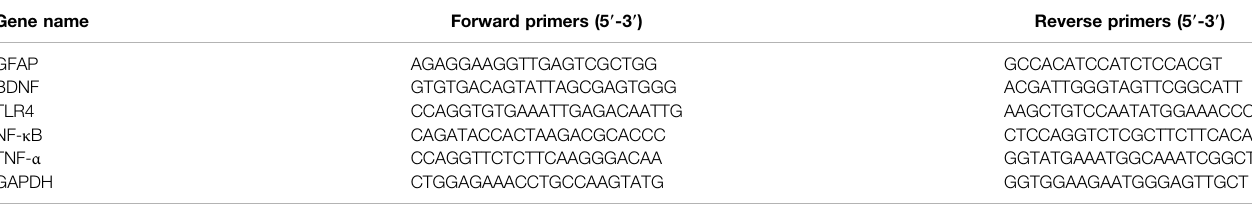
GFAP, glial fi brillary acidic protein; BDNF, brain-derived neurotrophic factor; TLR4, toll-like receptor 4; NF- κ B, nuclear transcription factor-kappa B; TNF- α , tumor necrosis factor α ; GAPDH, glyceraldehyde-3-phosphate dehydrogenase.